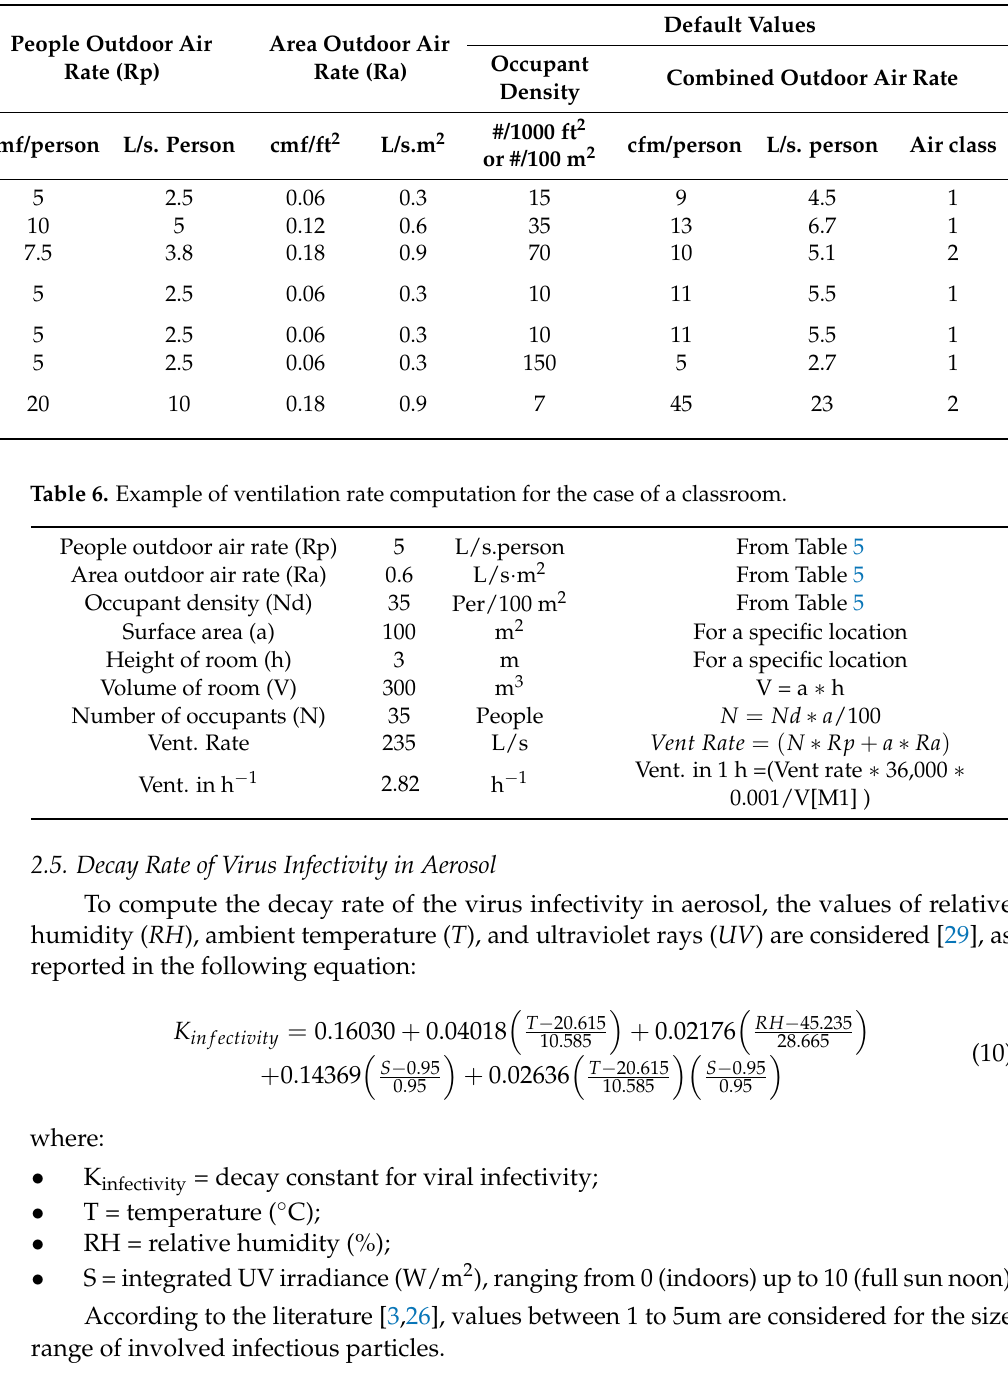
Table 5. Minimum Ventilation Rates in Breathing Zone.